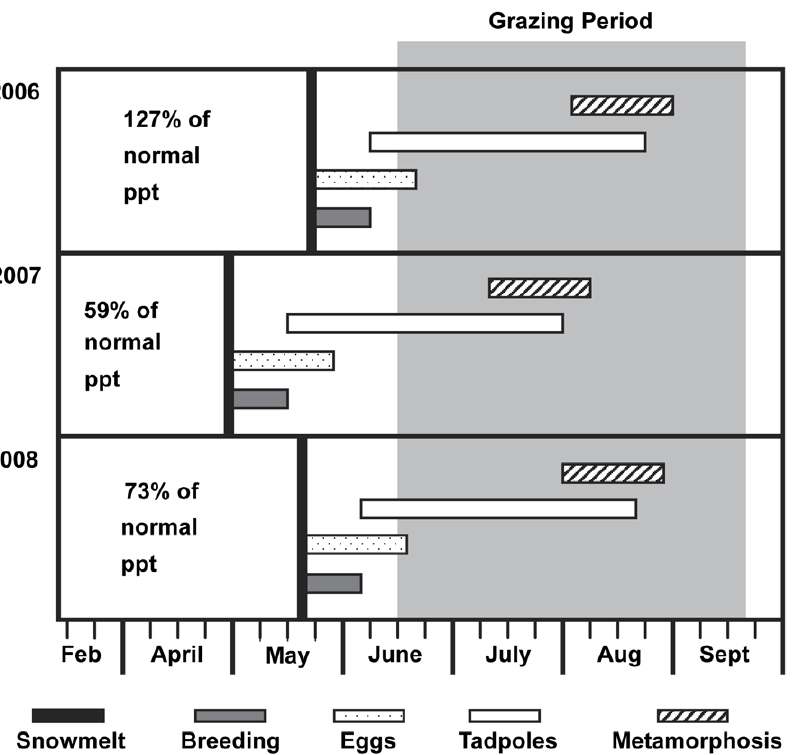
Figure 1. Life stage progression. Diagram illustrating timing of Yosemite toad ( Anaxyrus [= Bufo ] canorus Camp) life stages and cattle grazing seasons in the High Sierra Ranger District, Sierra National Forest, California, USA. Data were collected for 2006 to 2008 on cattle grazed meadows in the study area [77,78].